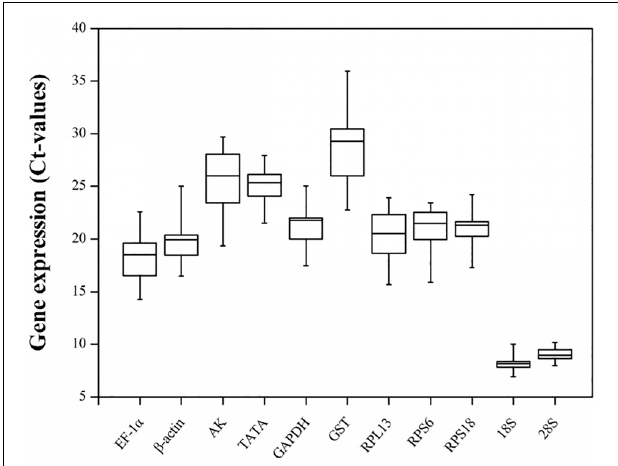
FIGURE 1 | Candidate reference gene expression profiles in R. padi. Expression data are presented as mean Ct values for duplicate samples. Whiskers represent the maximum and minimum values. The lower and upper borders of boxes represent the 25th and 75th percentiles, respectively. The line across the box indicates the median Ct value.